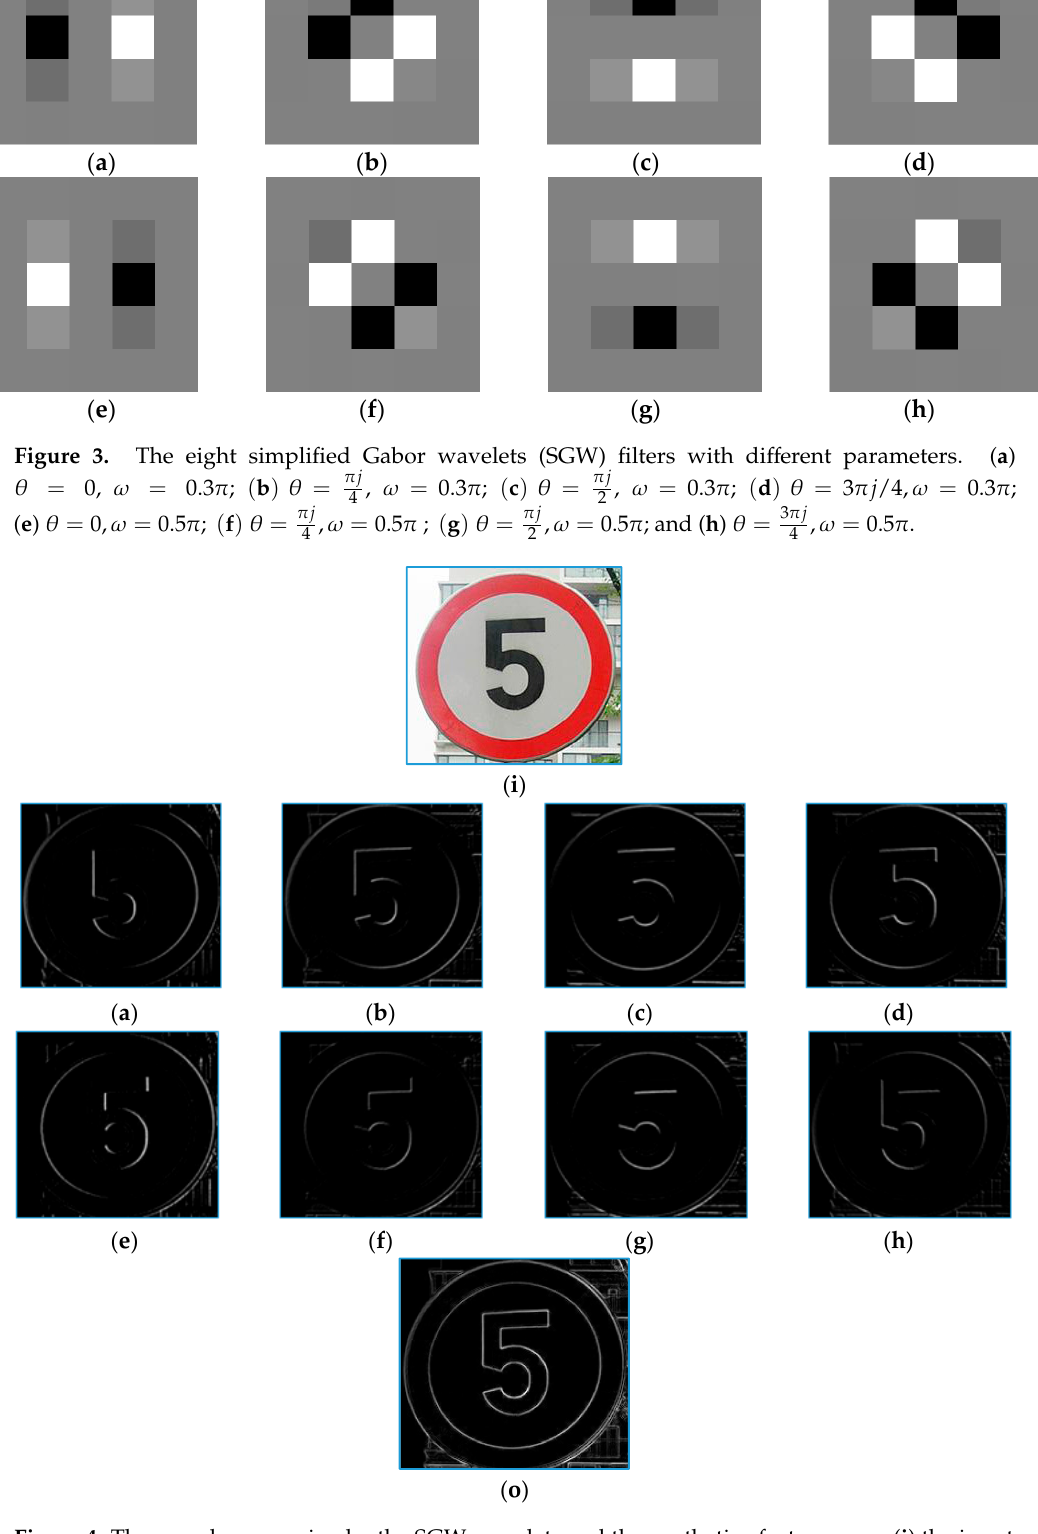
Figure 4. The sample processing by the SGW wavelets and the synthetize feature map: ( i ) the input image; ( a – h ) filtered by kernels corresponding to Figure 3, and ( o ) synthetize feature map.